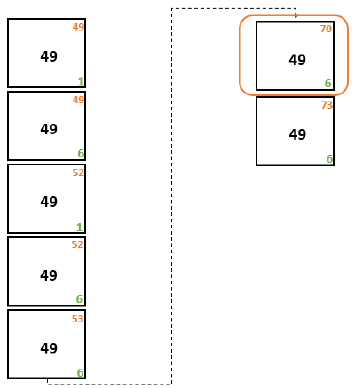
Figure 13. Possible collaboration partners for division 49 as an input to the company